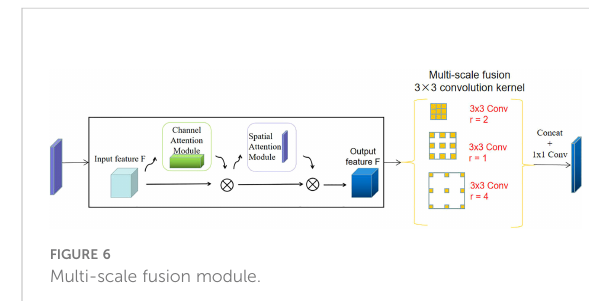
FIGURE 4 Channel Attention Mechanism structure diagram.